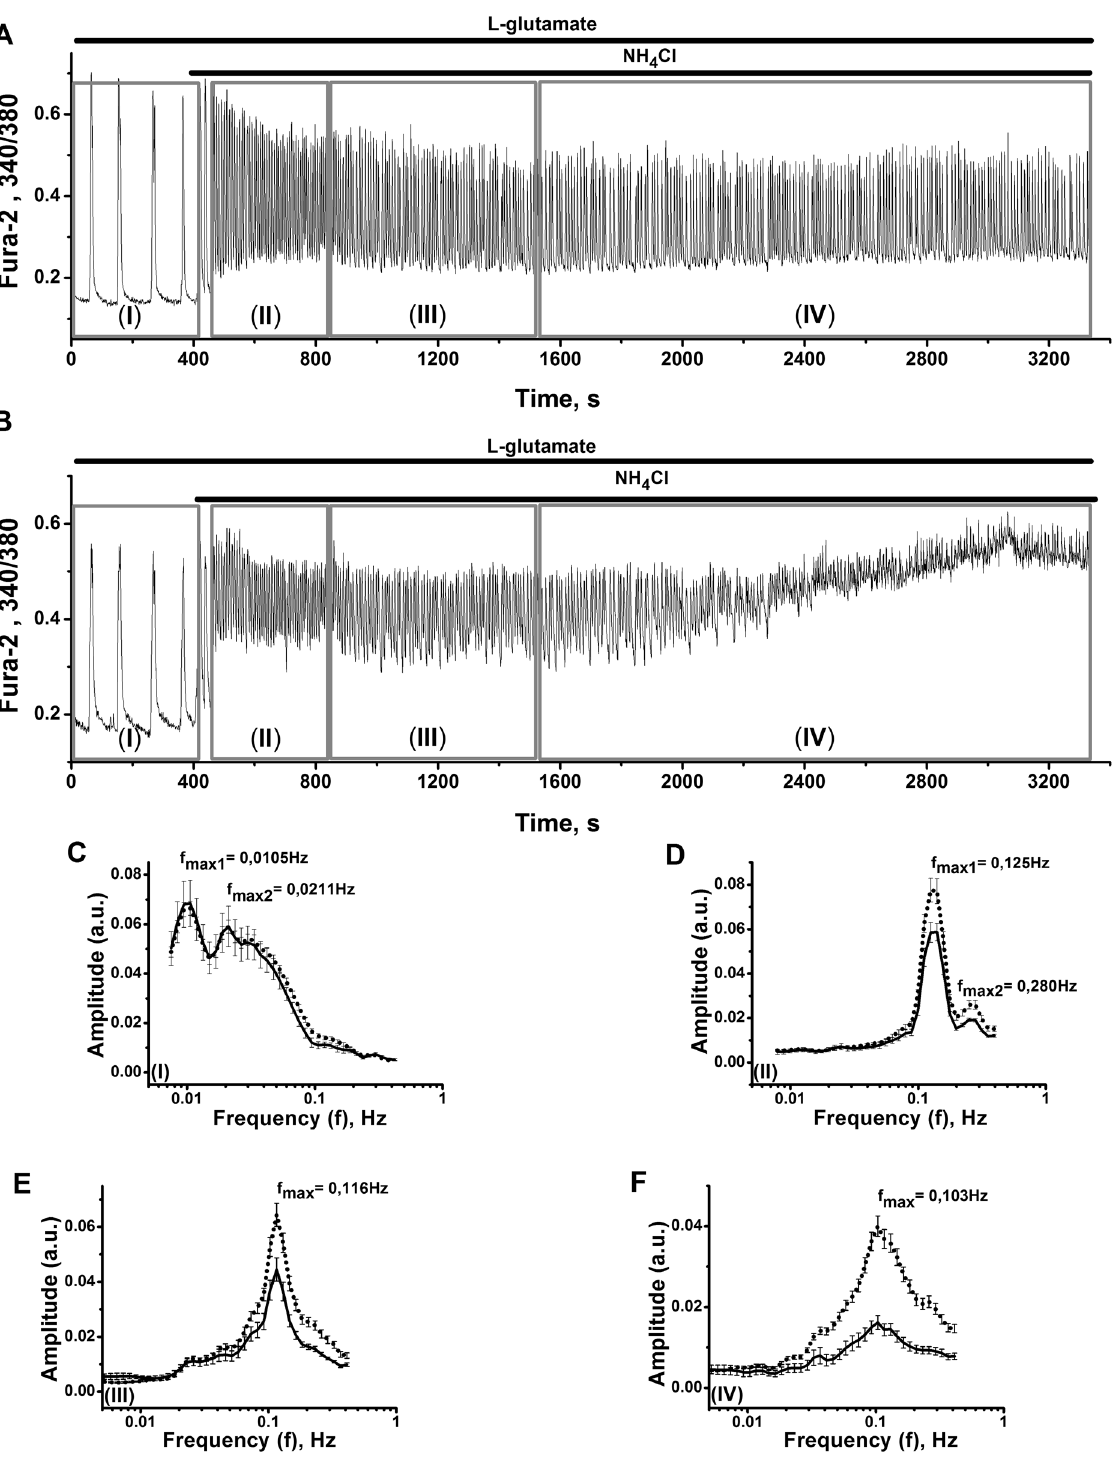
Fig 4. The records of Ca 2+ oscillations (A, B) and Amplitude-frequency (A-f) spectral characteristics of Ca 2+ oscillations (C – F) of two groups of neurons in network, observed after long lasting application of 6mM NH 4 Cl. Neuronal culture 14 DIV. Total number of cells involved into network is 123. 200 nM of L-glutamate was added before application of 6 mM NH 4 Cl. (A) The record describing typical response of one of 95% cells in the network (of representative cell). (B) The record characterizing one of 5% «run out» cells, which after time point 2000 seconds slowly moves to the state with enlarged Ca 2+ . (C – F) A-f spectra of two groups of cells (of typical and «run out» cells) are calculated for time intervals limited by boxes (I), (II), (III) and (IV) at Fig 4A